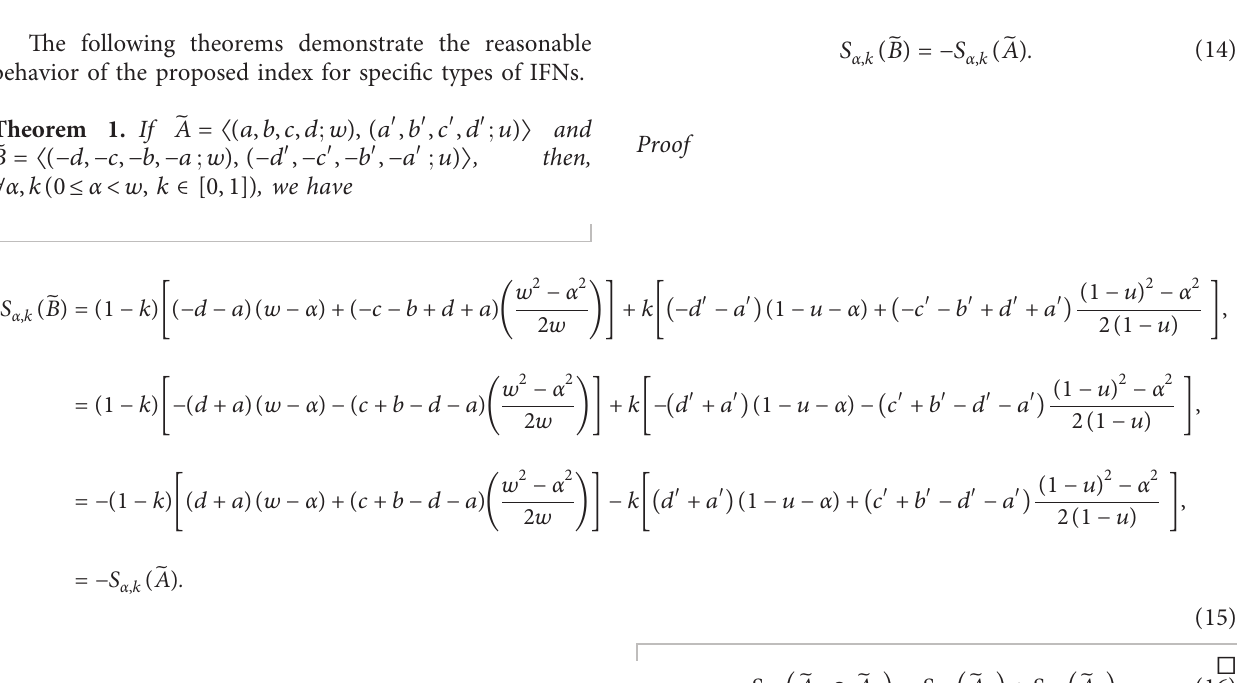
index with k � 0 (a) and k � 1 (b). α ,k